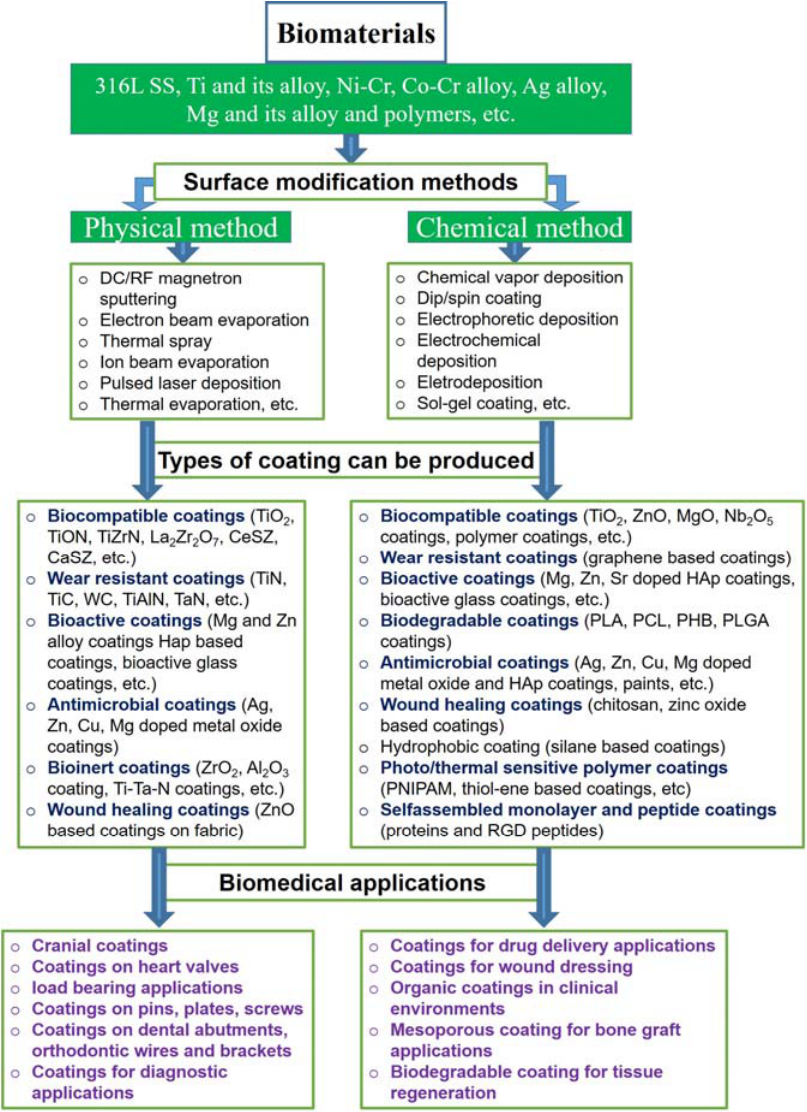
Figure 1. Schematic view of types of biomaterials, choices of coatings and its biomedical applications.